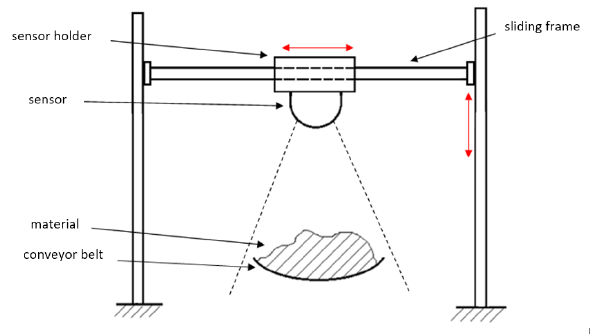
Figure 9: Rigid frame with sliding crossbar in 1 axis and a